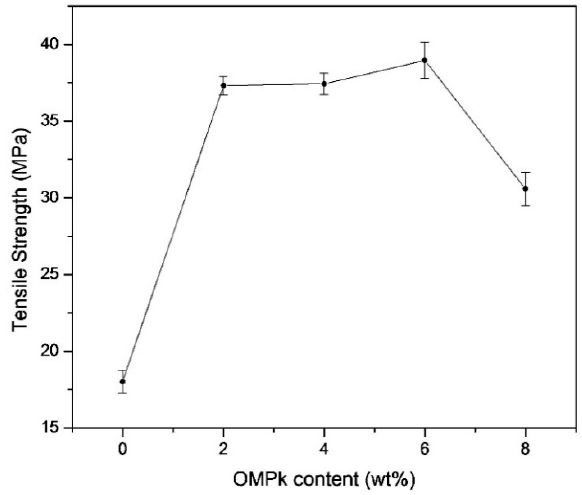
Figure 9. Graph of the tensile strength with respect to the O -methylene phosphonic κ -carrageenan (OMPk) content.